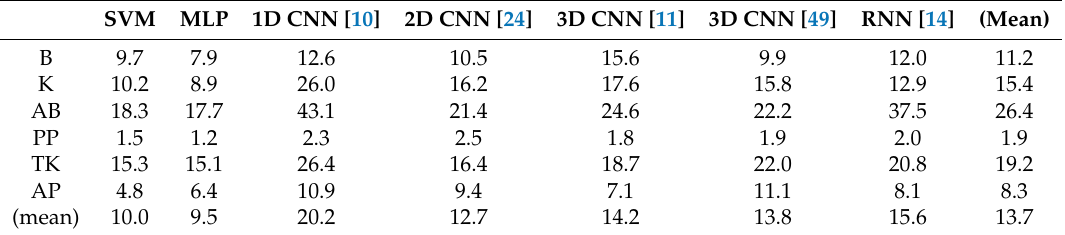
Table 4. Per-class percentage of errors for each method, aggregated over transductive experiments with E/comparision scene images (second part of the HTC